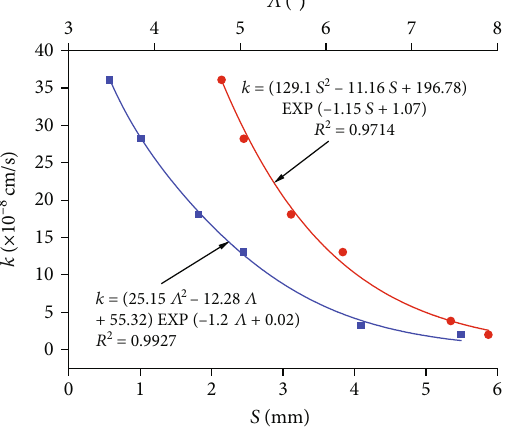
Figure 23: Relationship between k and S or Λ